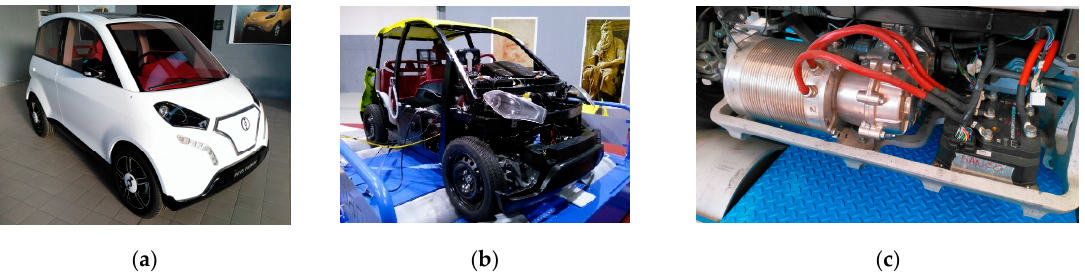
Figure 1. The case study 4-wheel-drive (4WD) electric vehicle platform prototype: ( a ) Exterior view; ( b ) The EV during testing on a rolling road facility; ( c ) The 2-speed electric powertrain.